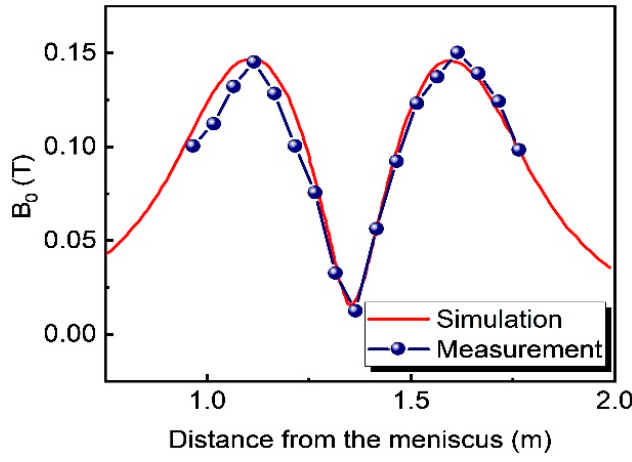
Figure 3. Comparison of the calculated and measured magnetic flux density distribution in slab mold. 3.2. Comparison between the Calculated and Measured Velocities near the Mold Surface In our previous works, the method for quantitative measurement of the velocity near the mold surface at high temperature, named the rod deflection method, was devel- oped [24,25]. Figure 4 is a schematic diagram of the rod deflection method. The velocity measuring device is composed of a detecting rod, a deflection bearing, a deflection angle indicator and a balance block. After the detecting rod is inserted into the liquid steel, the detecting rod deflects under the impact of the liquid steel flow. After the deflection angle indicator is stable, the deflection angle is read, and the liquid steel velocity near the mold surface can be obtained through the relationship between the deflection angle and the liquid steel velocity. The velocity near the surface of one-quarter width of the mold is measured with the rod deflection method.